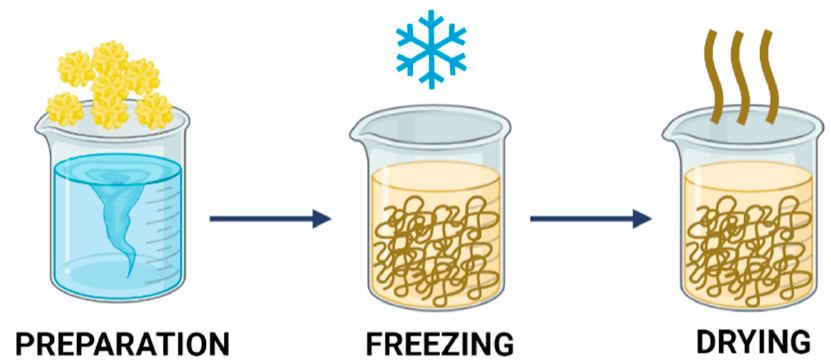
Figure 4. Formation of porous materials by lyophilization.